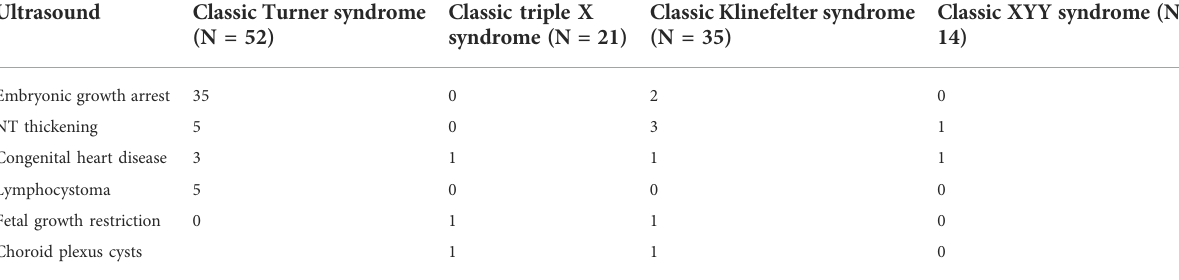
TABLE 1 Clinical phenotypes of fetuses with classic sex chromosomal aneuploidies. Ultrasound